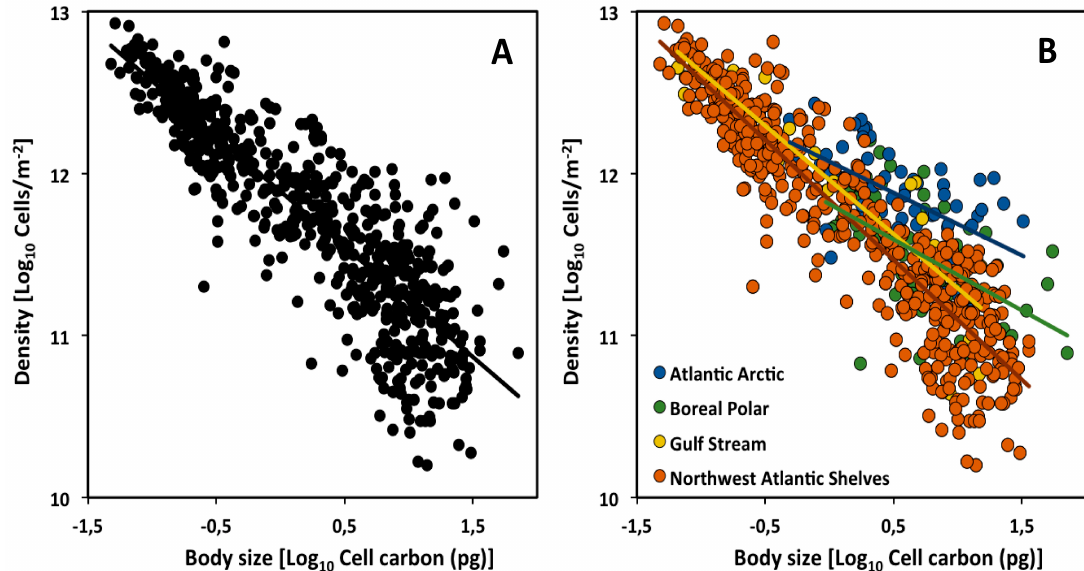
Figure 1. Scaling of cell density versus cell size (carbon mass) of phytoplankton communities in the Atlantic Ocean (data from [27]): ( A ) CCSR for all assemblages; ( B ) CCSRs of each of four major assemblages occupying four major climate zones (biogeographic regions): Atlantic Arctic, Boreal Polar, Gulf Stream and Northwest Atlantic Shelves. Table 1. Results of the LSR analyses of log10 population density (cell / m − 2 ) in relation to log10 body size (cell carbon) of phytoplankton communities in the Atlantic Ocean (data from [27]). CCSR Slope 95% CI Intercept